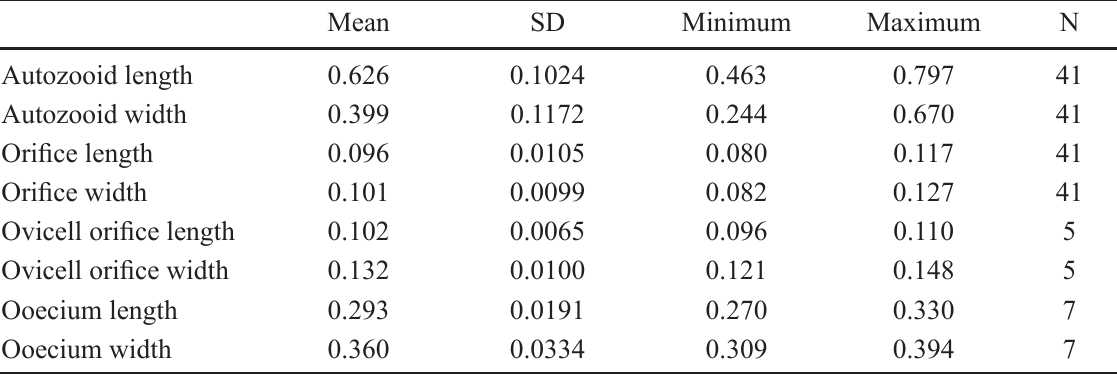
Table 1. Measurements (in mm) of Pulpeirina amoena (Jullien & Calvet, 1903) comb. nov. (lectotypes and paralectotypes). SD = standard deviation; N = number of